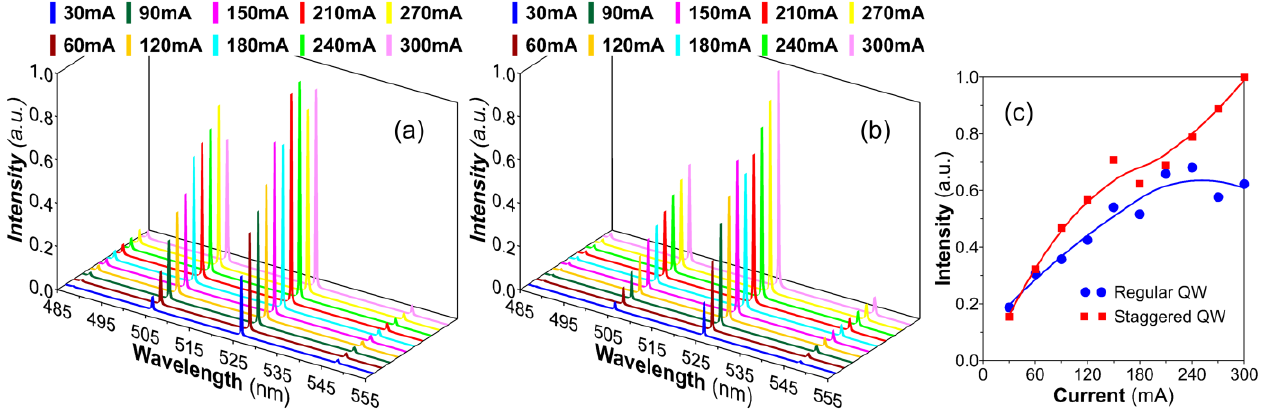
Figure 9. Electroluminescence spectra of the green μ-RCLEDs with ( a ) regular and ( b ) staggered MQWs. ( c ) Output power as a function of the input current for the two μ-RCLEDs.